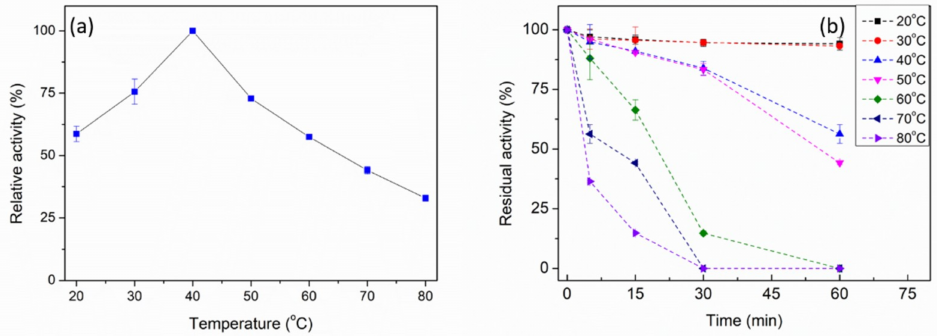
Figure 4. E ff ect of temperature on activity ( a ) and stability ( b ) of PpPel9a. The enzyme activity was detected by using 0.2% w / v PGA as a